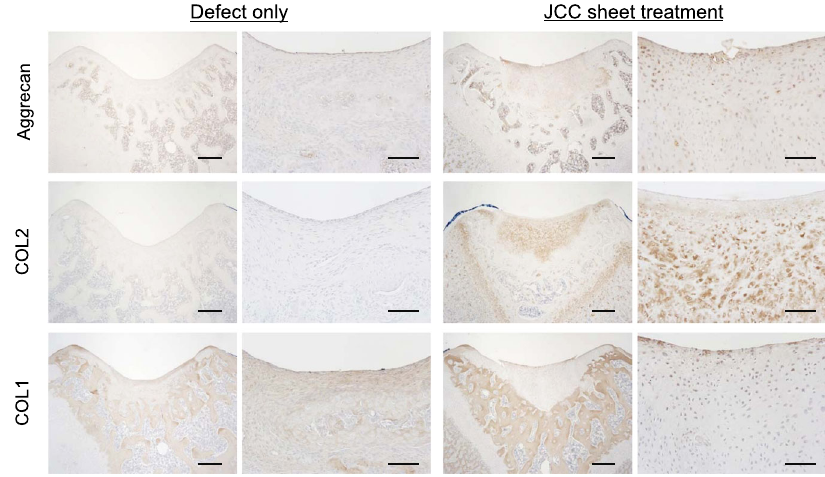
Fig. 5 Cartilage-speci fi c marker expression by transplanted human JCC sheet-derived tissue. Aggrecan staining (top), type II collagen staining (middle), type I collagen staining (bottom) are shown. All samples shown are 4 weeks after transplantation. Bars: Left columns of each treatment group: 500 µm, right columns of each treatment group: 100